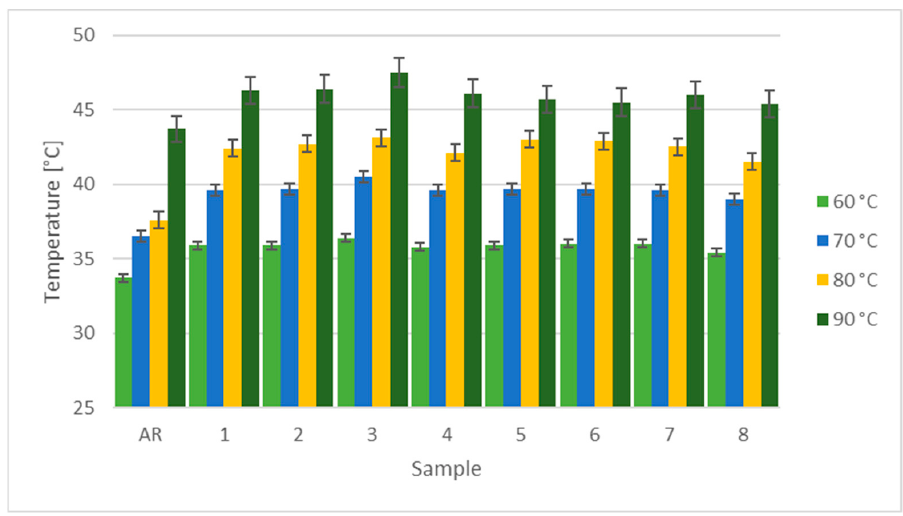
Figure 9. Regression analysis: ρ vs. Ra ( p -value = 0.000).